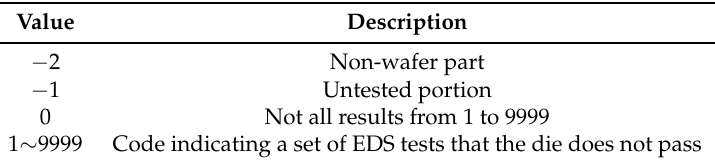
Figure 2. Example of WBM. Table 1. Values that can be assigned to WBM image